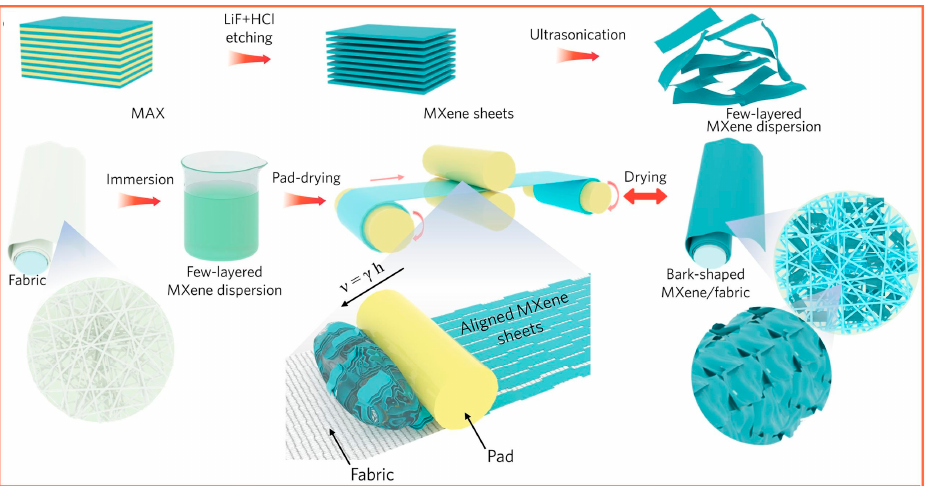
Figure 2. Illustration of the preparation of bark-like Mxene decorated cellulose fabrics. From [34], copyright (2022), with permission from Elsevier.